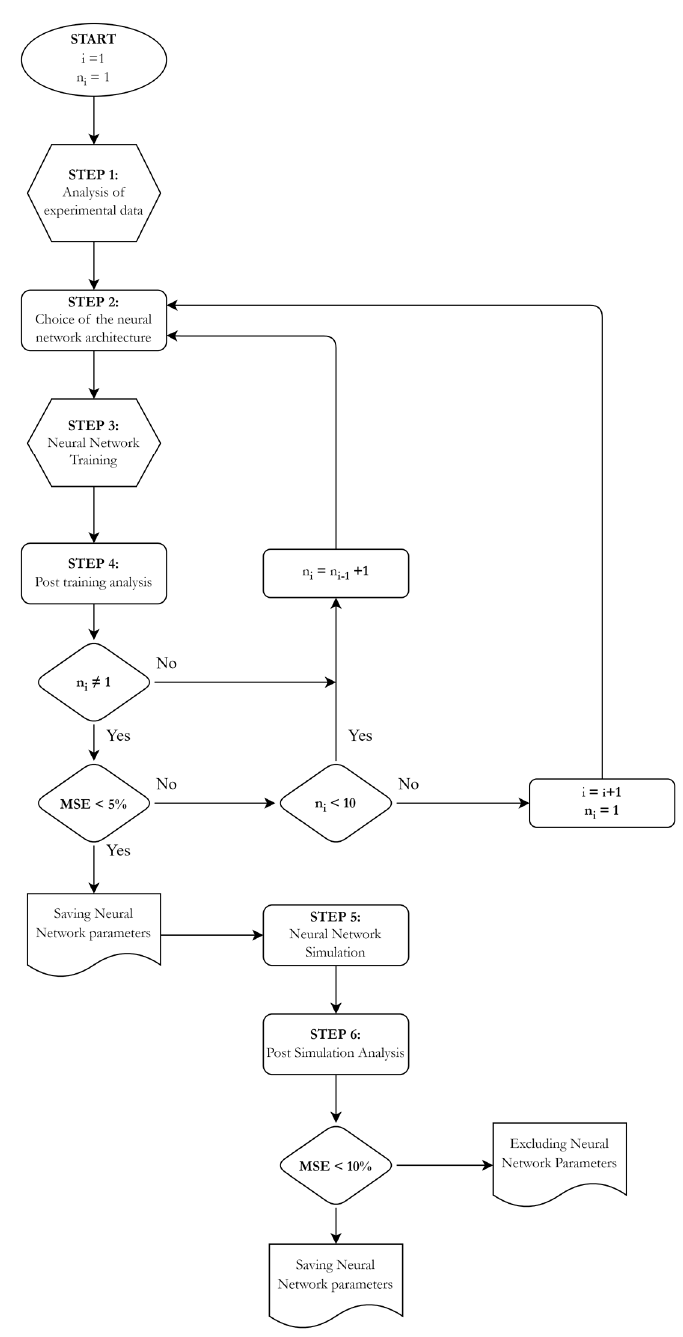
Figure 1. Artificial Neural Network trial-and-error step procedure.